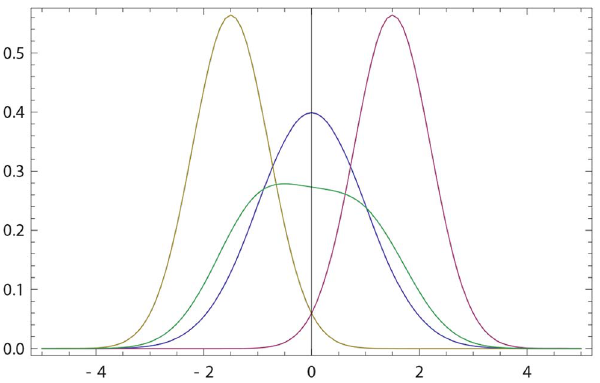
Figure 4. Order of presentation effect. Blue curve: The initial opinion of P is described by Gaussian probability density p ( x ) with m P ~ 0 and v P ~ 1 ; see (17). Purple (resp. olive) curve: the initial opinion of Q (resp. Q ’ ) are given by (17) with m Q ~ 1 : 5 (resp. m Q ’ ~{ 1 : 5 ) and v Q ~ 0 : 5 (resp. v Q ’ ~ 0 : 5 ). Green curve: the resulting opinion of P after interacting first with Q and then with Q ’ . Both interactions use E ~ 0 : 5 . The final opinion of P is inclined to the most recent opinion (that of Q ’ ) both with respect to its maximally probable value and distance. The final opinion of P has a larger width than the initial one.